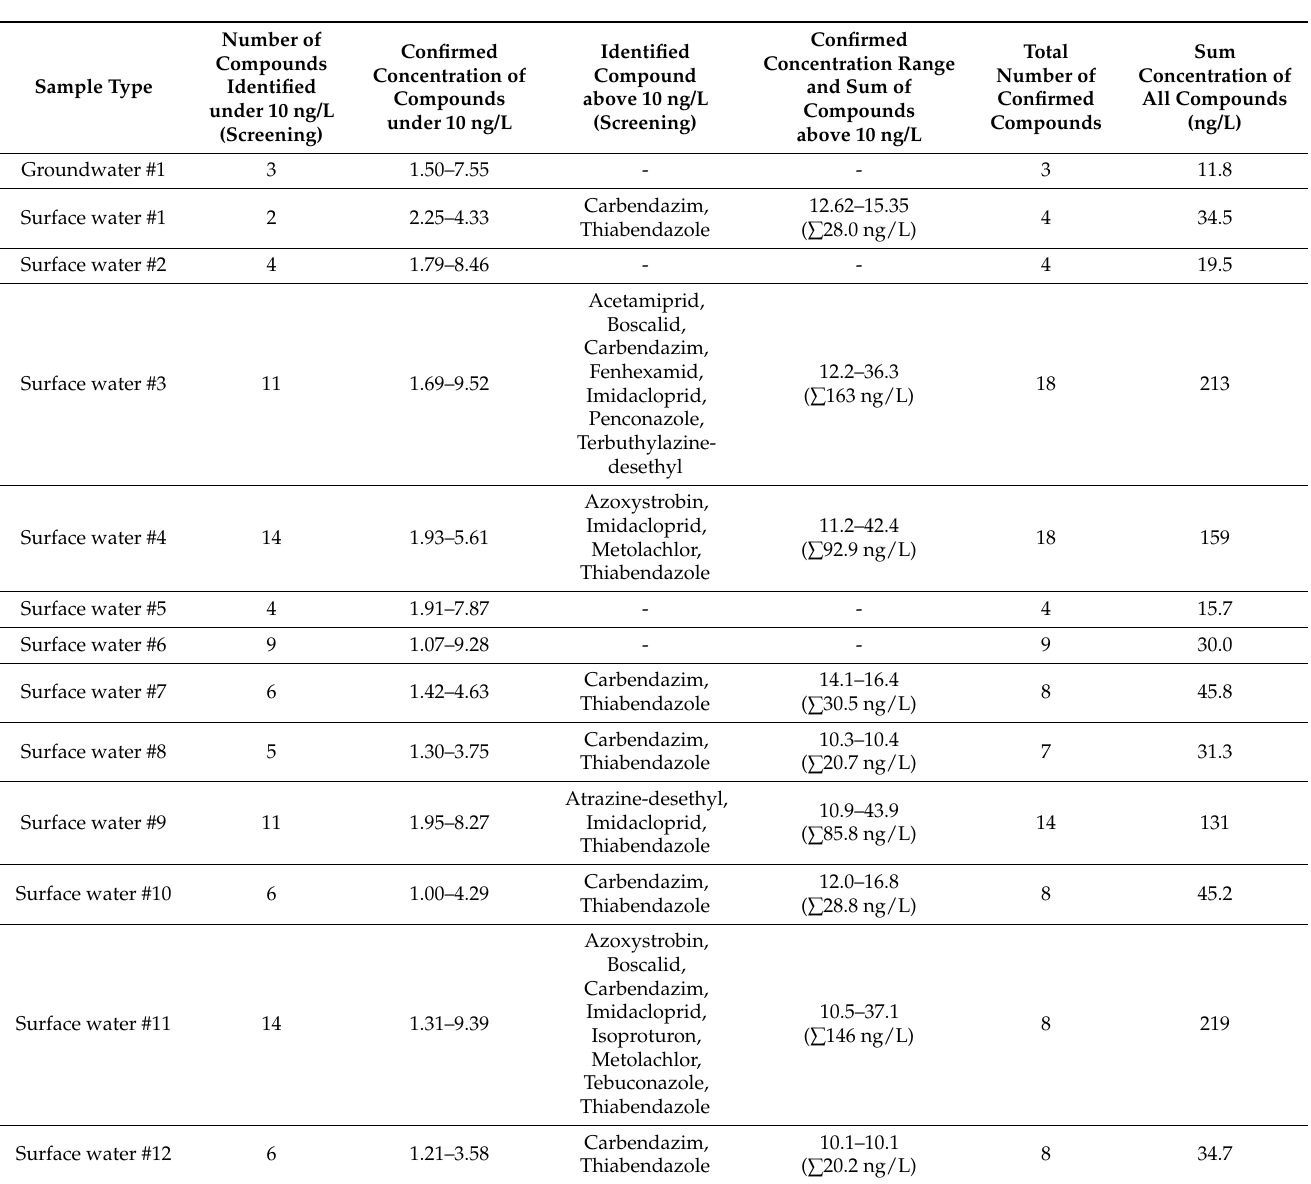
Table 2. Results of real sample analysis: Identified compounds under and above 10 ng/L and the total concentration. The detailed results are in Table